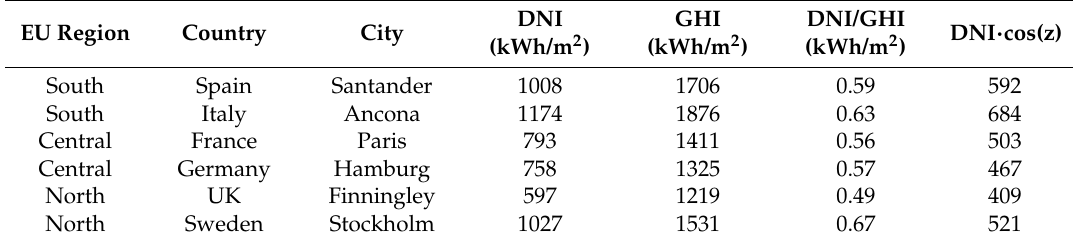
Table 1. Selected cities and their different climatic